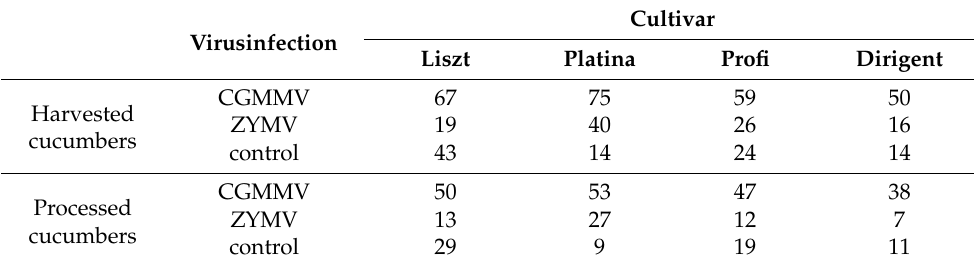
Table 1. Number of harvested and processed cucumbers, sorted by cultivar, virus infection Zucchini yellow mosaic virus (ZYMV), Cucumber green mottle mosaic (CGMMV)) and control. Cultivar Virusinfection